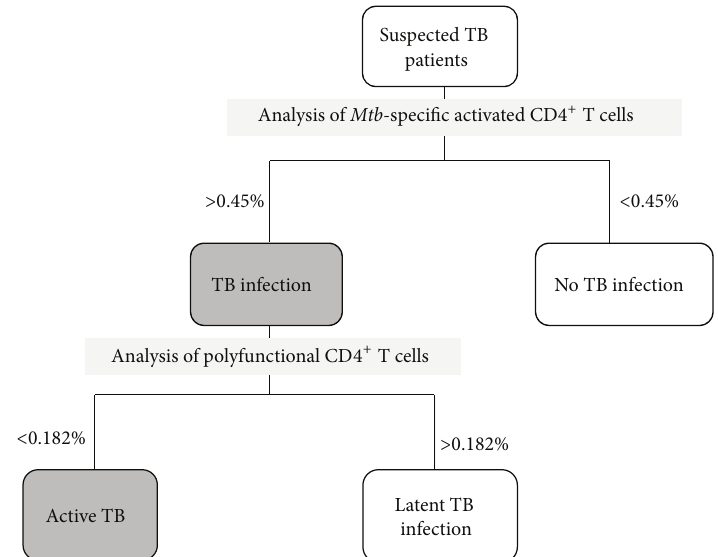
Figure 7: Proposed immune-based model for detection of active and latent TB. Taking into account the analysis of activated CD4 + T cells, it is possible to differentiate Mtb -infected subjects ( > 0.45%) by uninfected subjects ( < 0.45%). With the analysis of multifunctional CD4 + T cells, simultaneously producing all 3 cytokines, infected individuals may be classified as active TB subjects ( < 0.182%) or as LTBI subjects ( >